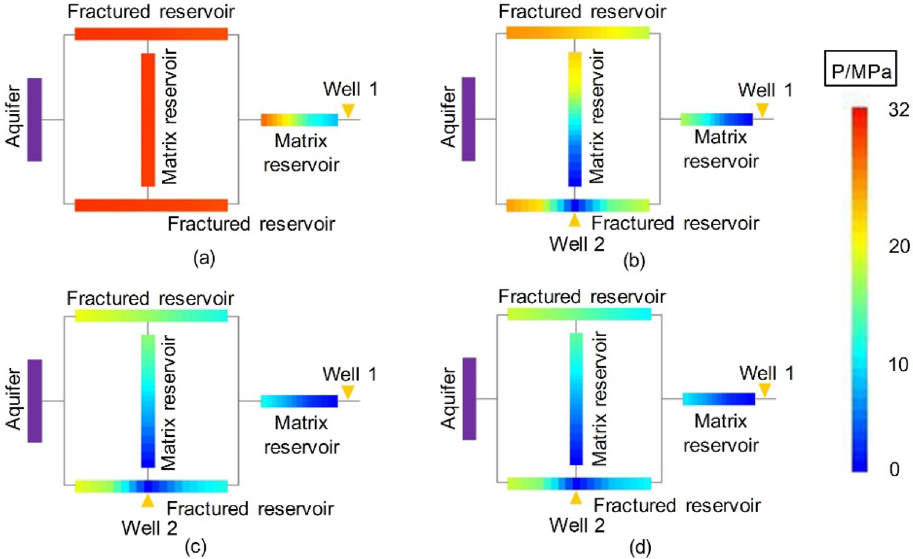
Figure 21. Pressure distributions at different stages of Experiment 4-1 (Model 2, infinite aquifer): ( a ) stable production of Well 1 ended -23 min, ( b ) end of the stabilized period of Well 2—45 min, ( c ) late production period -70 min, and ( d ) gas well production halted—142 min.